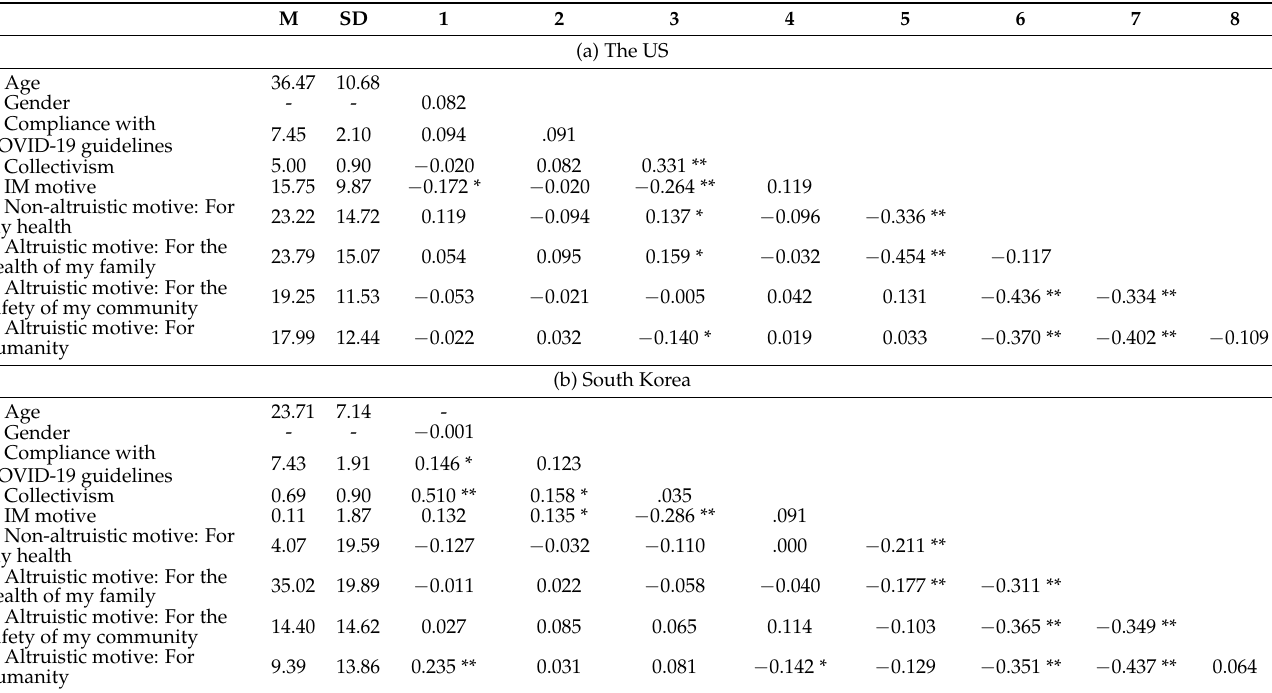
Table 1. Descriptive statistics and correlations among